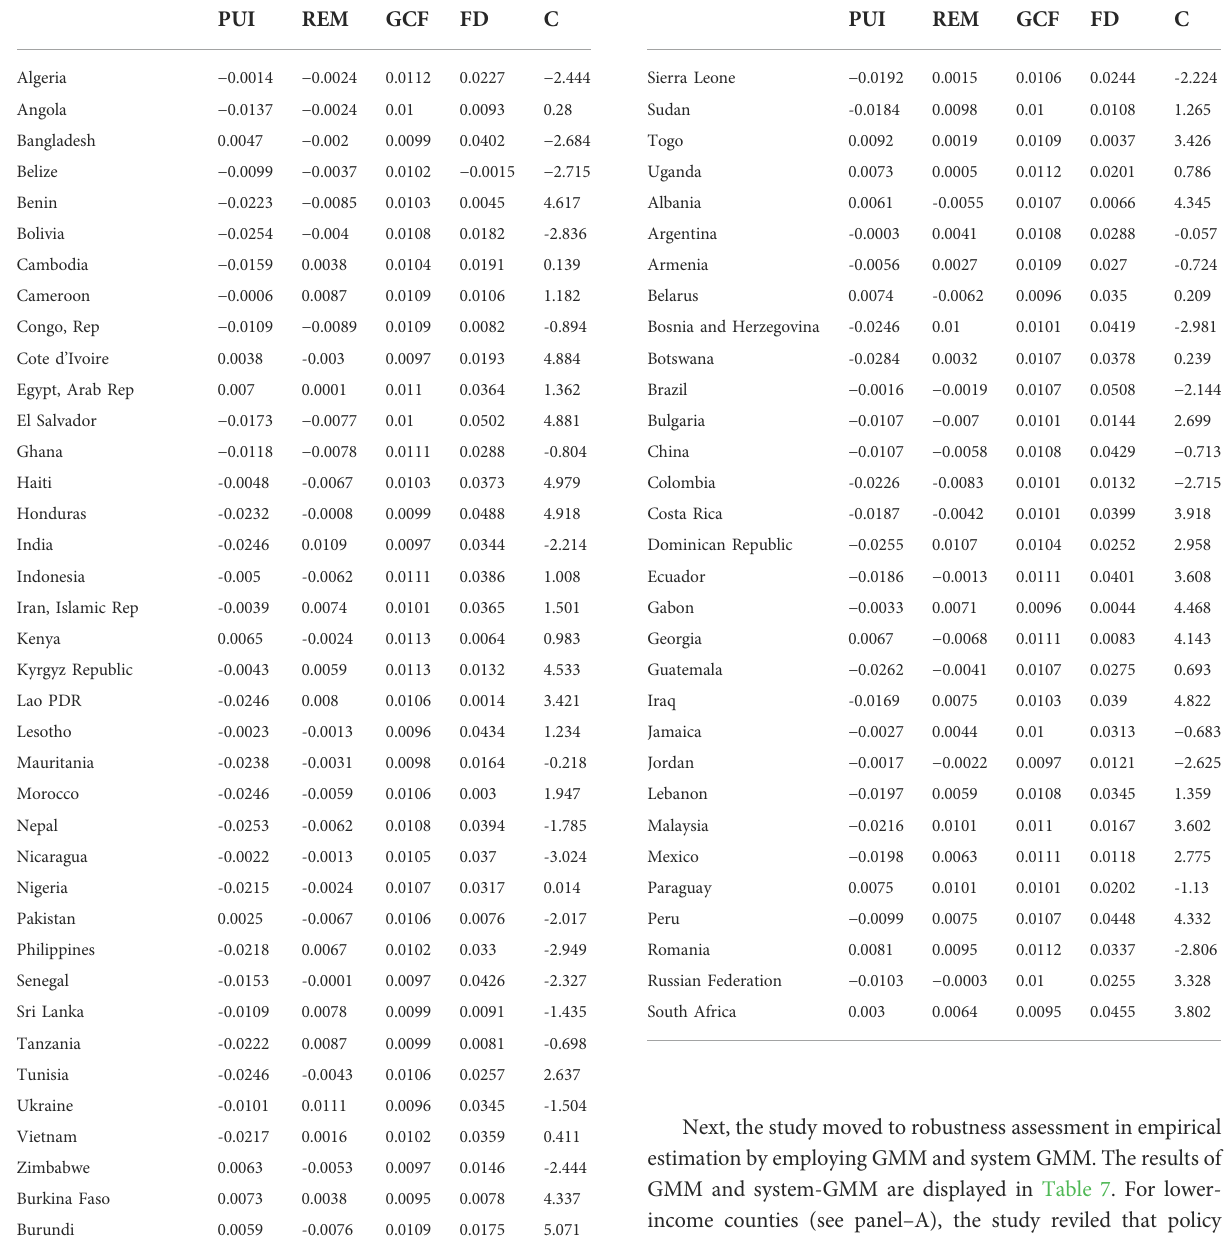
TABLE 8 Country-wise